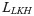
(a) LKH cycle (LLKH). (b) Edges 1 to t-1 in LLKH in Fig 1A are moved into the CEL, and the CEL is expanded after p-nodes P1,P2 are selected and inserted into the R-path (squares represent the base station, triangles represent p-nodes, hollow circles represent d-nodes to be filled, and solid circles represent filled d-nodes).